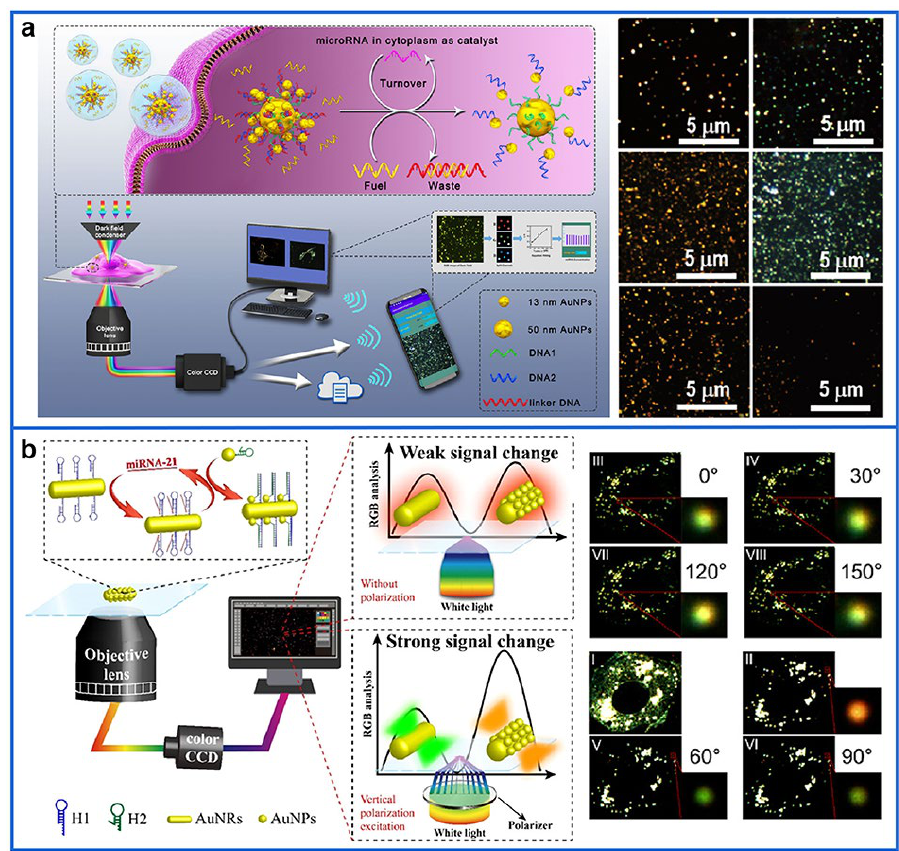
Figure 4. ( a ) Principle of the algorithm-assisted miRNA detection and imaging system. ( b ) Schematic diagram of low-background and high-sensitivity detection of miRNA under vertical polarization excitation. Reprinted with permission from [144,146]. Copyright 2021 and 2020, American Chemical Society.